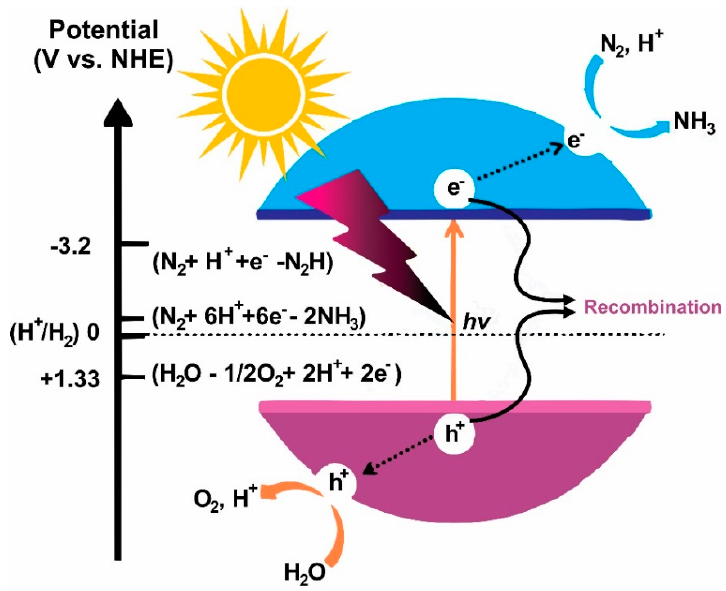
Figure 6. Schematic of photocatalyst reaction for ammonia synthesis [68].